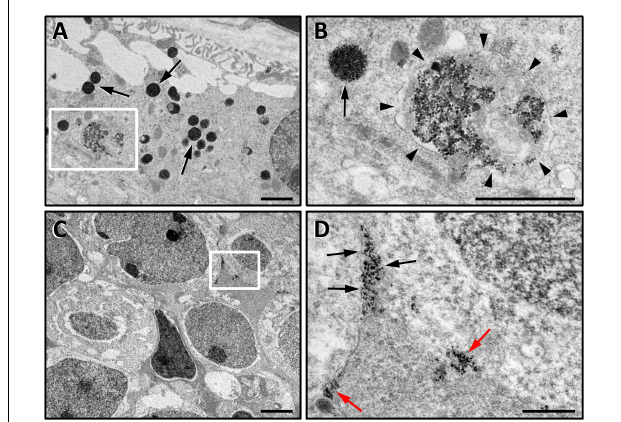
FIGURE 7 | High resolution TEM images of ultrathin retinal sections at the level of the RPE (A,B) and of the INL (C,D) . Images in (A,B) are from a Balb/c mouse retina, in which RPE cells do not contain pigment and therefore MNP-OCT can be easily detected. (B) is a higher power of the boxed area in (A) . In the RPE, MNP-OCT were found to be internalized in several endocytic vesicles. The scission phase of endocytic process releasing primary endocytic vesicle is highlighted by arrowheads (B) , while other MNP-containing vesicles are likely to represent different stages of the following intracellular trafficking ( A,B , arrows). (D) is a higher power of the boxed area in (C) . The nanoparticles in the INL were densely packed into narrow intercellular spaces ( D , black arrows) or distributed in dense spots adjacent to the extracellular side of the plasma membrane of INL cells ( D , red arrows). Scale bars, 1 µ m in ( A , B , D) ; 2 µ m in (C)